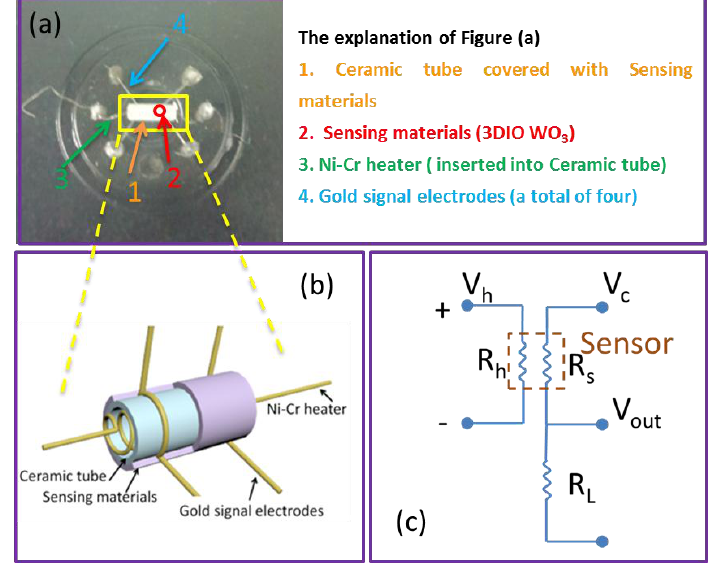
Figure 2. ( a ) Photograph of the 3DIO WO 3 gas sensor, ( b ) the schematic structure of the gas sensor, and ( c ) the schematic diagram of the electrical circuit for measuring the 3DIO gas sensor.